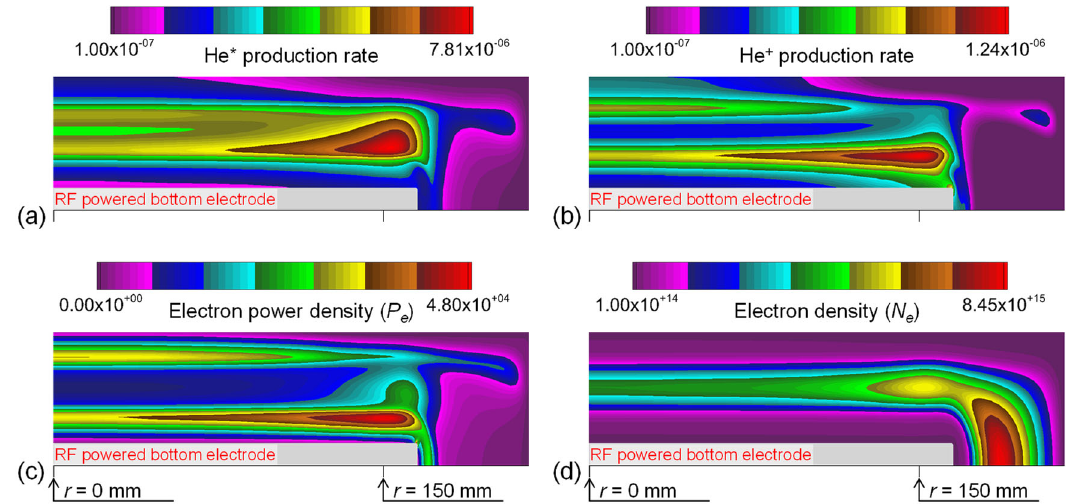
Figure 2. Contour plots for the spatial profiles of the time ‐ averaged ( a ) He* production rate for Case 1 and ( b ) He + production rate for Case 1 for r ≥ 0 mm. Contour plots for the spatial profiles of the time ‐ averaged ( c ) electron power density (W m − 3 ) for Case 1 and ( d ) electron density (m − 3 ) for Case 1 for r ≥ 0 mm.